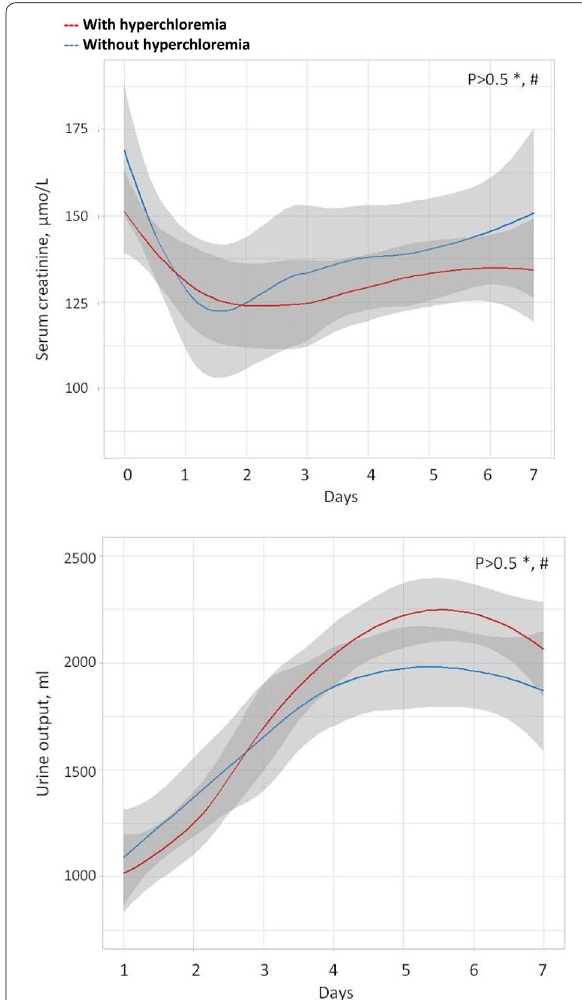
Fig. 2 Evolution of renal function between patient with and without hyperchloremia from H0 to day-7 among patient free of RRT at H0. Means and 95% IC are provided. * p value for comparison at H0. # p value for comparison of the evolution over time (results of Generalized Non-Linear Mixed